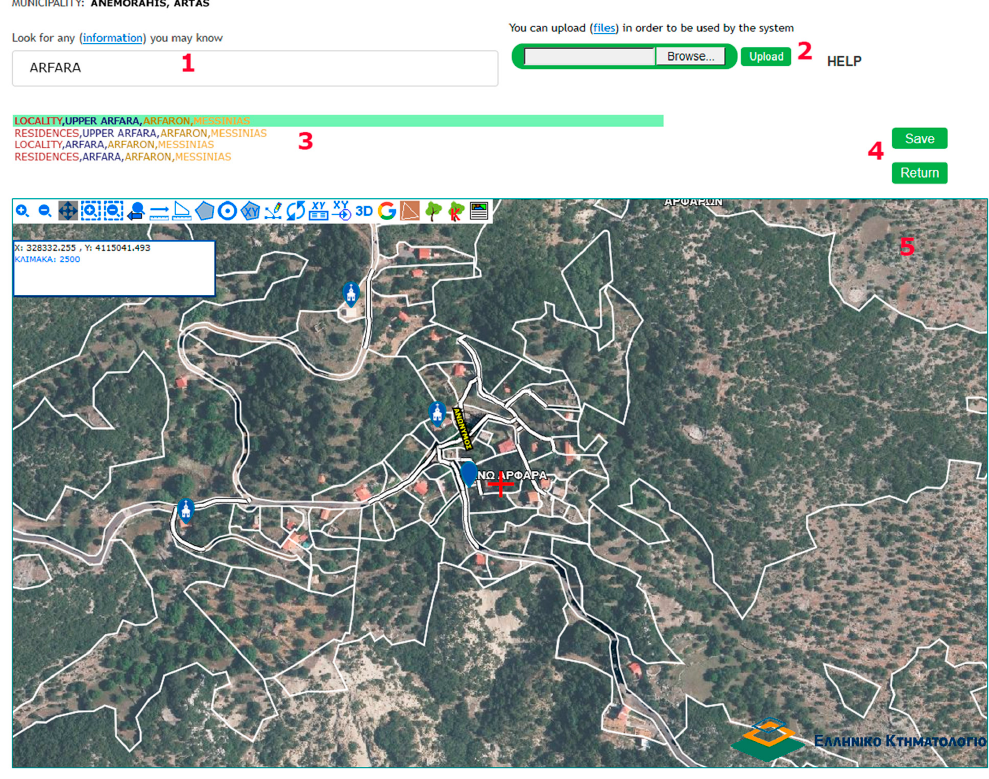
Figure 4. Main areas of Location Service.